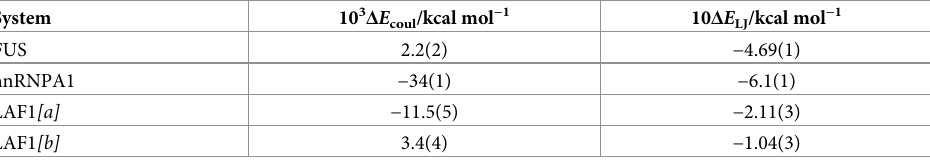
a change almost exclusively to the hydrophobic part of the pairwise energy. For hnRNPA1 and LAF1 [a] , both Coulomb and hydrophobic interactions are more favourable in the evolved sequences, but hydrophobic interactions contribute more in absolute terms. For LAF1 [b] , the Coulomb energy is less favourable in the evolved sequence. All data presented here are obtained at a simulation temperature of 200 K, corresponding to 0.8 T c (FUS). While the overall average ener- gies themselves depend significantly on temperature, the differences between WT and evolved sequence energies are largely independent of temperature in the range of interest.